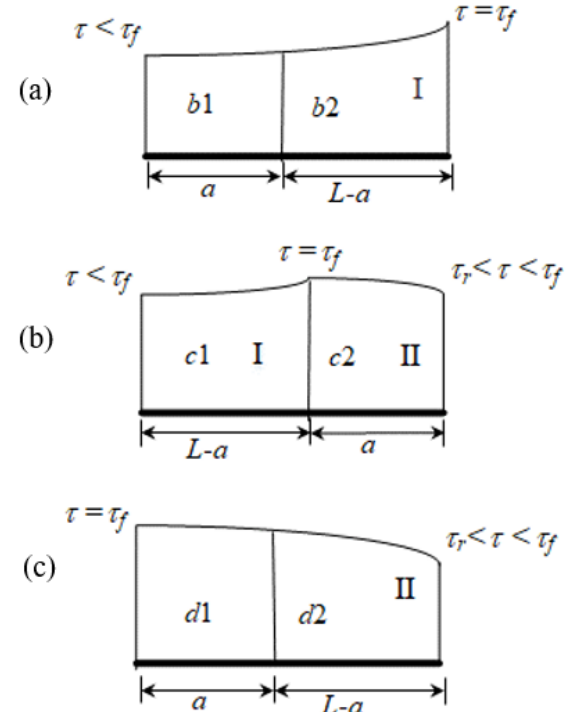
Figure 17. Area analysis of shear stress evolution for P max (Point B in Figure 16), ( a ): corresponds to Figure 15b; ( b ): corresponds to Figure 15c; ( c ) corresponds to Figure 15d. The value of a * can be identified by making the derivative of Equation (32) with respect to a zero: ∂